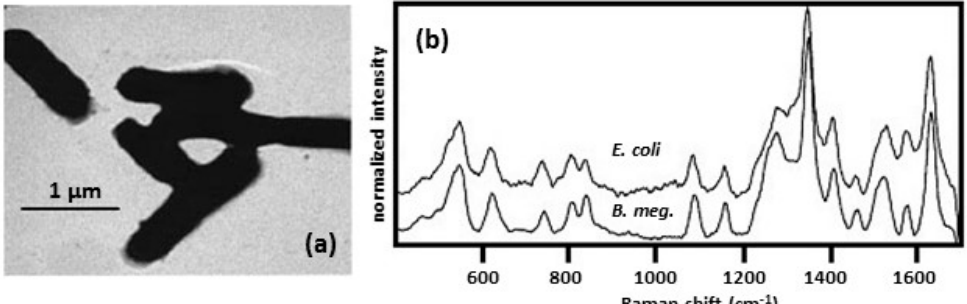
Figure 5. ( a ) TEM image of E. coli with a wall colloid [30]. Reproduced with permission from